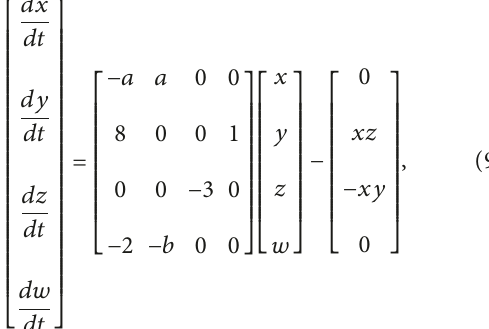
Figure 19: Phase portraits of Experiment 3 with a � 0 . 1 ,t � 100: ( a ) in y − z − w ( d 3